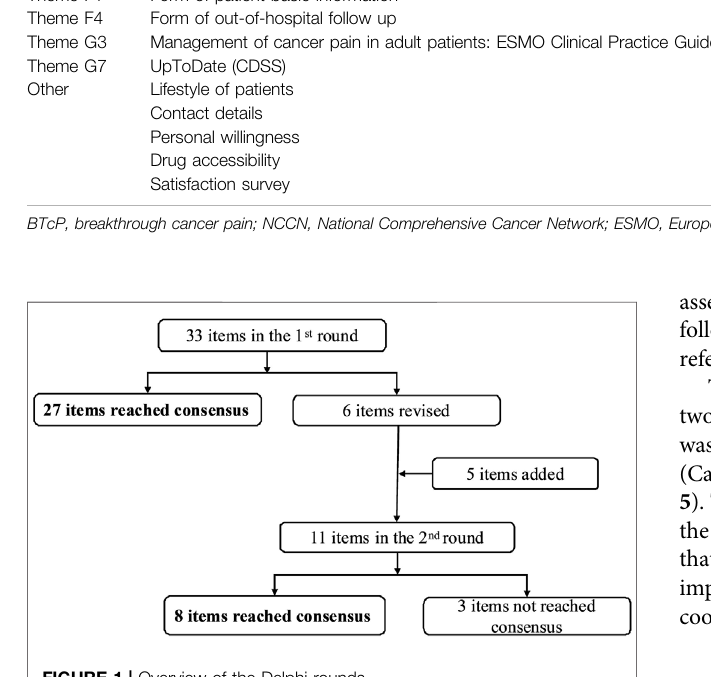
FIGURE 1 | Overview of the Delphi